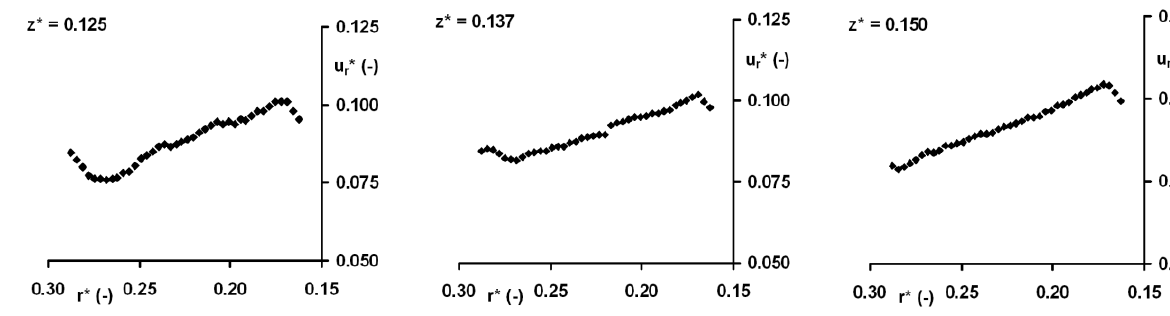
Fig. 8. Dimensionless radial fluctuation velocity profiles ) / ( N D u